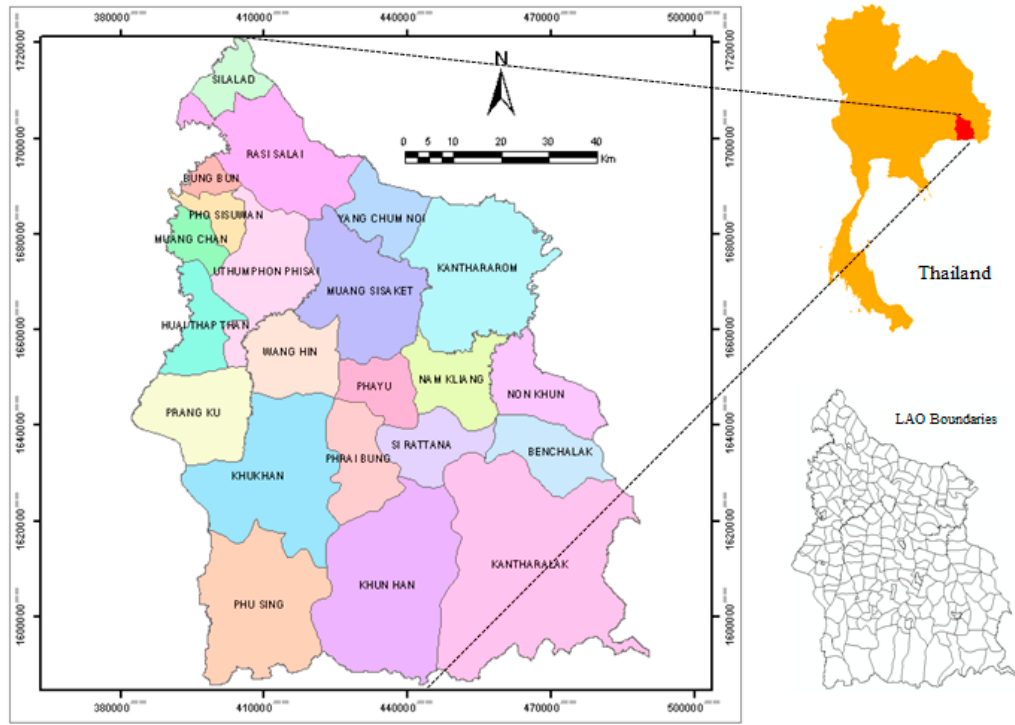
Figure 1. Map of Si Sa Ket province.